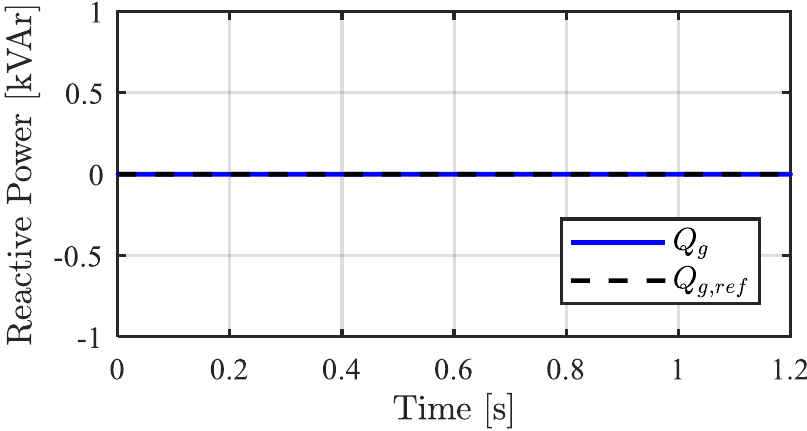
Figure 7. Reactive power to the grid time profile.